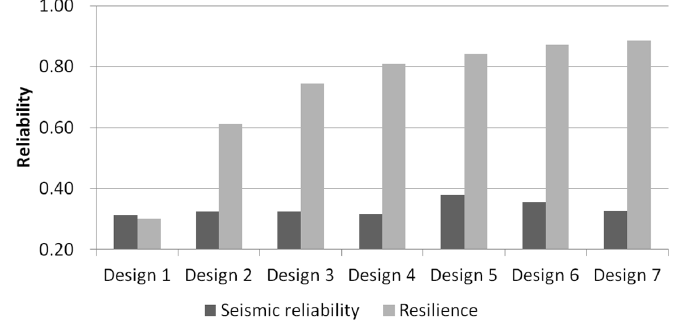
Figure 8. Seismic reliability of the seven uniform designs; all pipes are 508 mm in Case 5.